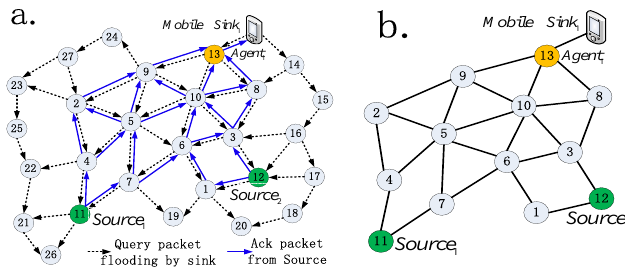
Figure 1. Illustration of ( a ) sink queries MWSN; ( b ) graphic description of MWSN.